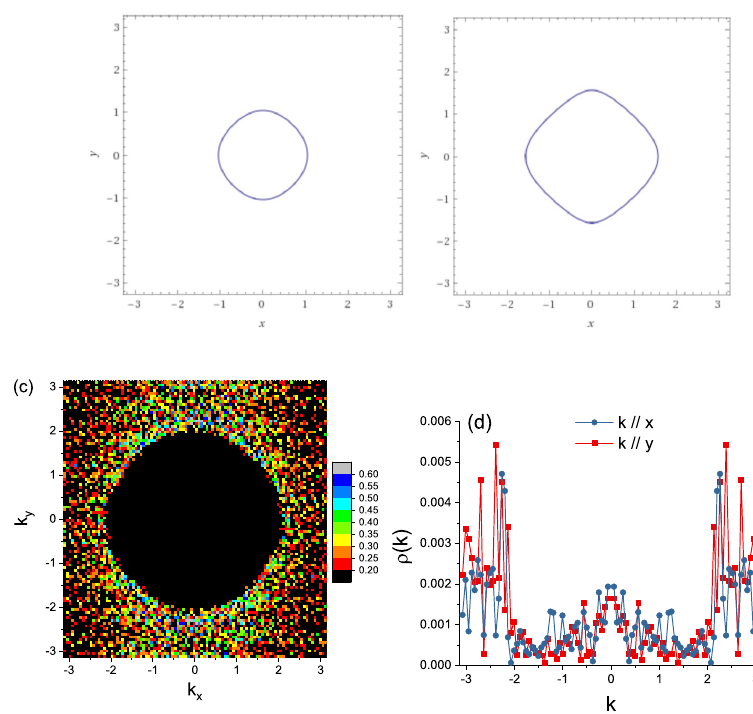
= 1.0, Figure 9: (a) The Fermi surface of the model in Eq. 8 with parameters t x = 0.5, ˜ t = 0.167, µ = − 2.333 leads to a nearly symmetric Fermi surface. (b) t y y = 1.0, t = 0.5, ˜ t = 0.25 and µ = − 1.5 shows Another example with parameters t x y y a nearly symmetric Fermi surface. (c) The Fourier transform of the LDOS ρ ( k ) and (d) ρ ( k ) along the high symmetry directions of (b) seem rather consistent with a